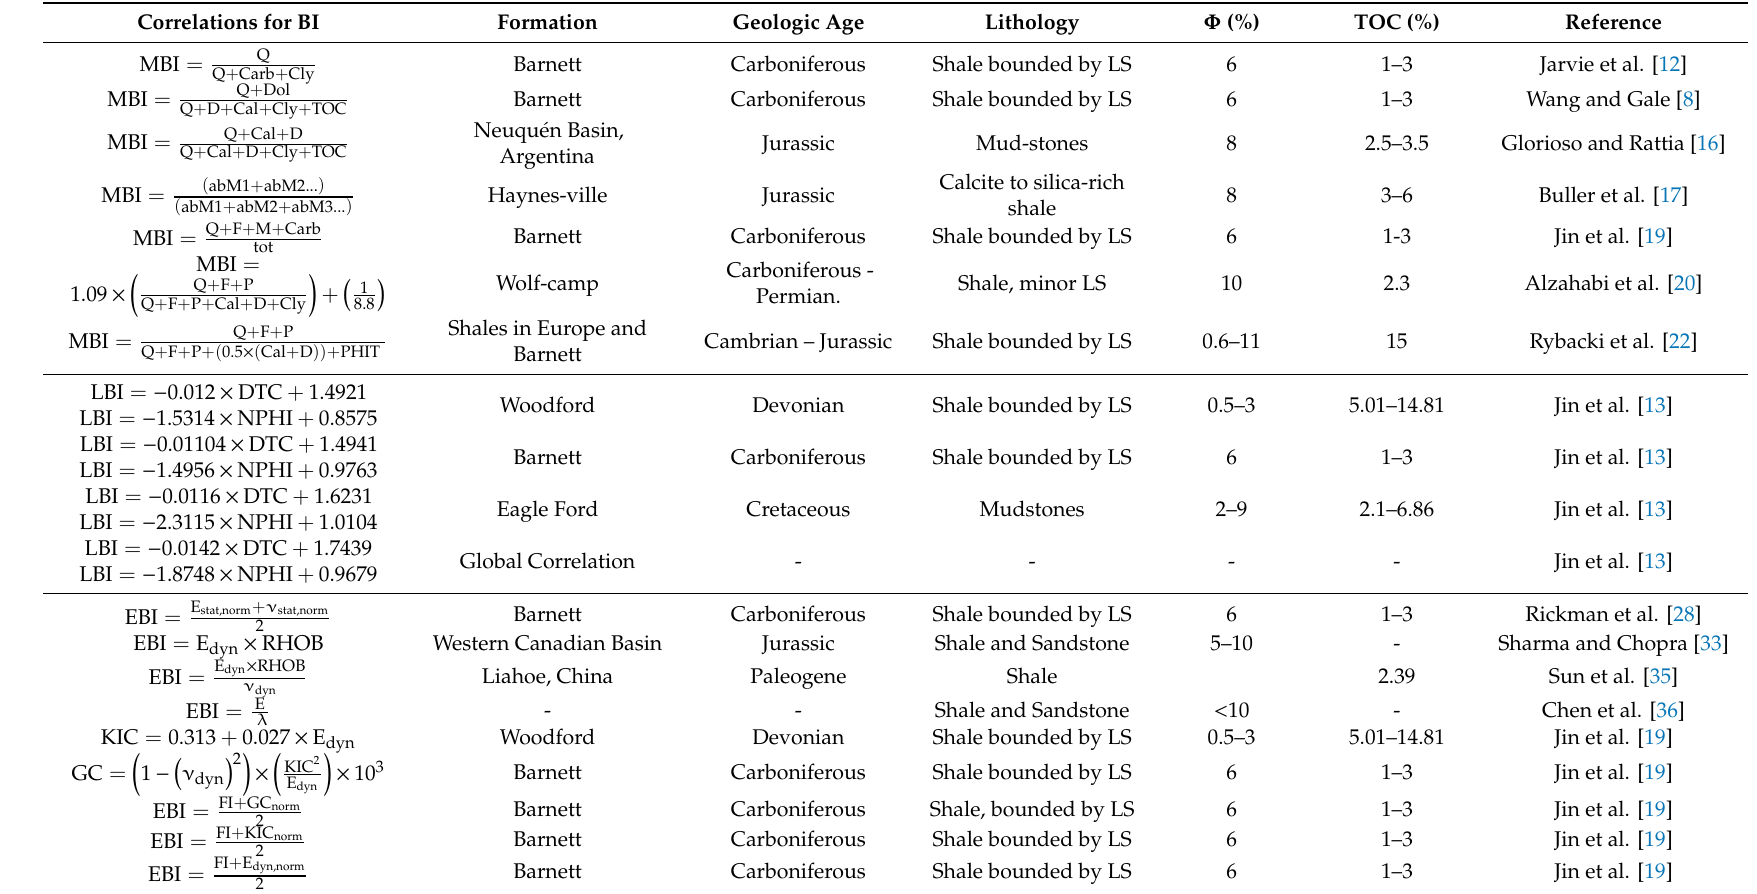
Table A1. Overall summary of existing correlations for the brittleness